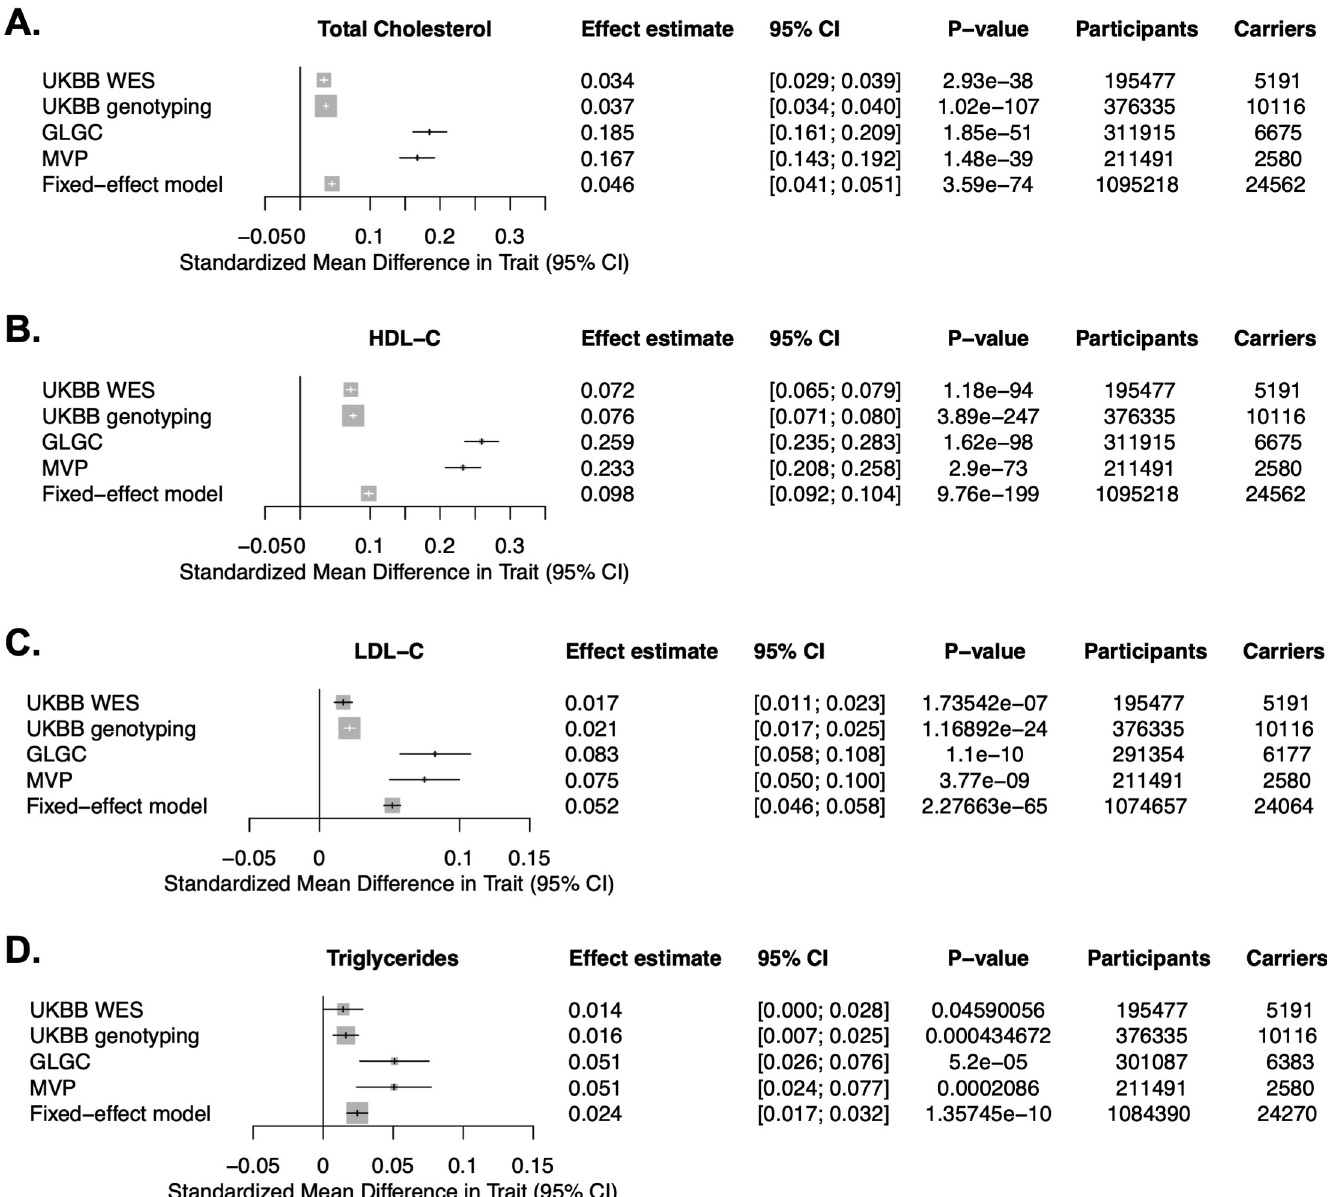
Fig 1. Association of the LIPG p.Asn396Ser variant with plasma lipids in humans. A-D . Association of LIPG p.Asn396Ser with plasma total cholesterol (A), HDL-C (B), LDL-C (C), and triglycerides (D) in the UK Biobank (UKBB) whole exome sequencing subset, UKBB genome-wide genotyping subset, Global Lipids Genetics Consortium (GLGC), and Million Veteran Program (MVP) cohorts, and a fixed-effects meta-analysis of these cohorts. Effect estimates after log-transformation for each lipid trait in standard deviation (S.D.) units and 95% confidence intervals are plotted.